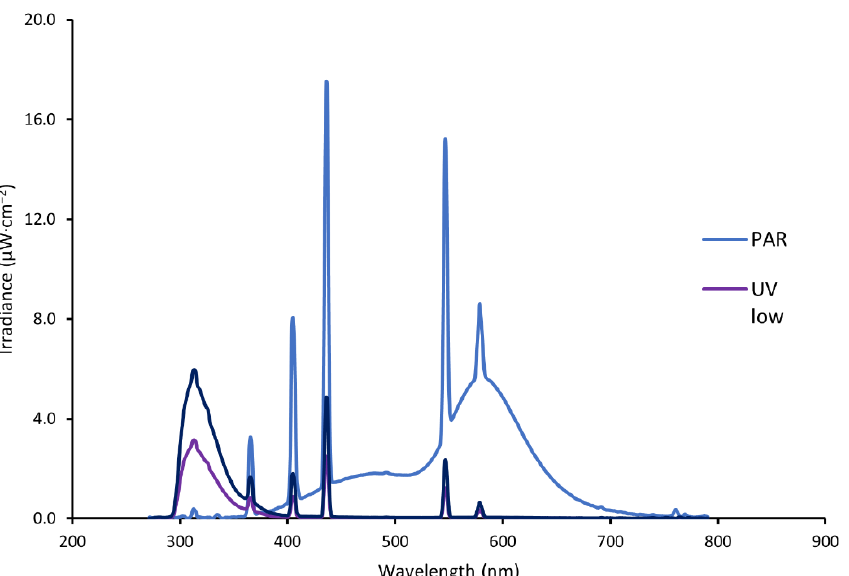
Figure 1. The plot shows spectral energy distribution in test chambers for the irradiation from TL-D 640 lamps giving mainly photosynthetic active radiation (PAR), and UV-B 313 El lamp (mainly ultraviolet radiation, UV-B and UV-A) at two levels: UV low (one lamp) and UV high (two lamps). Leaves were irradiated at a 65 cm distance with a UV-C filter 4 cm above the plants.